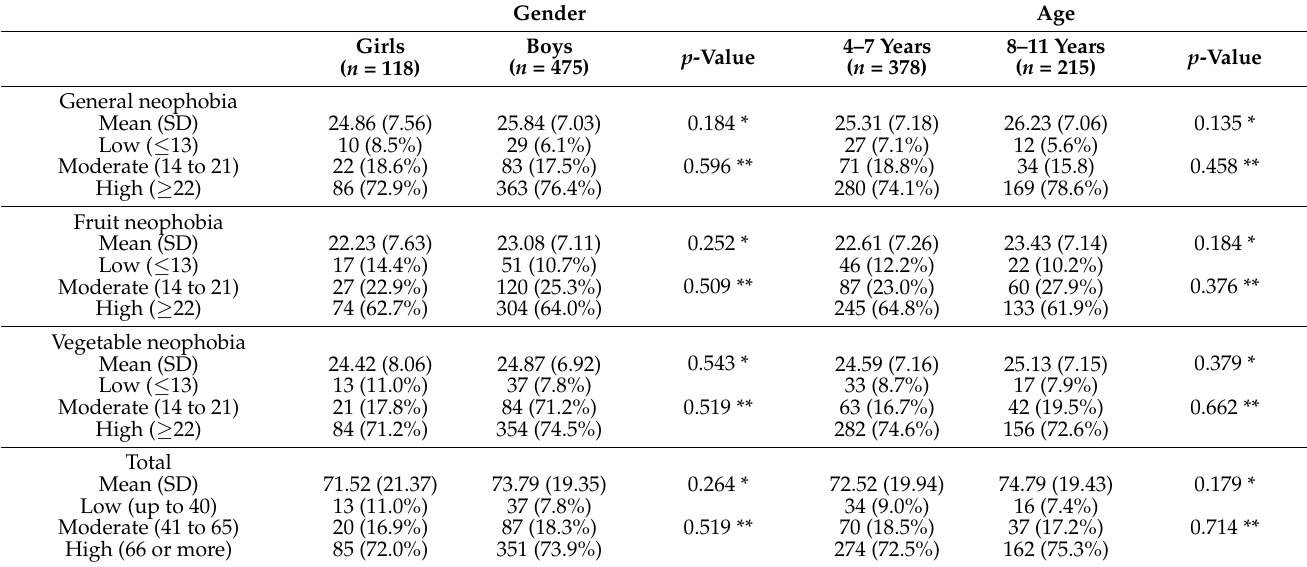
Table 2. Scores and distribution of the food neophobia classification by gender and age group in children with ASD (Brazil,